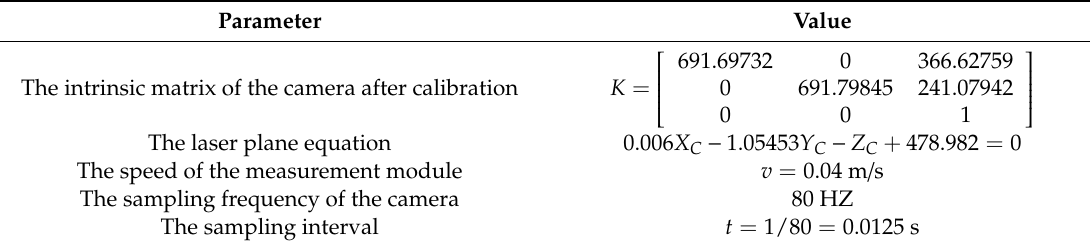
Table 4. The parameters in the 3D laser vision system.